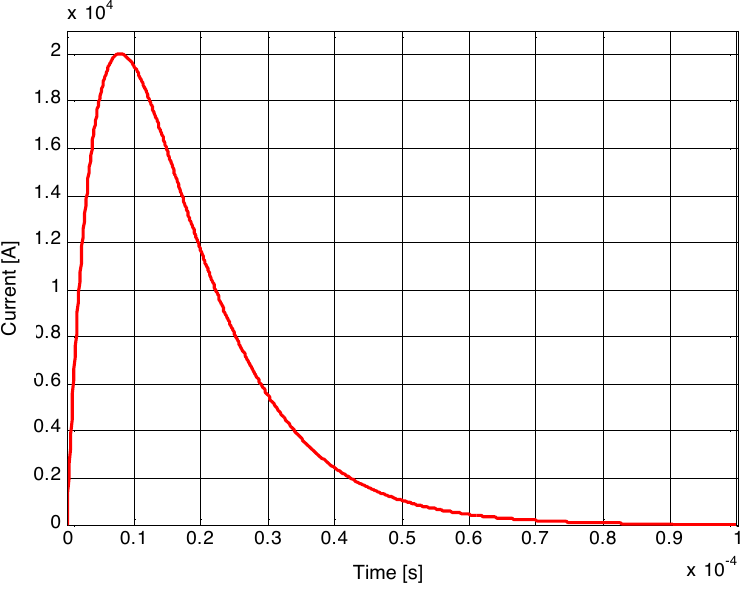
Fig. 7. The discharge current of 20 kA with impulse form 8/20